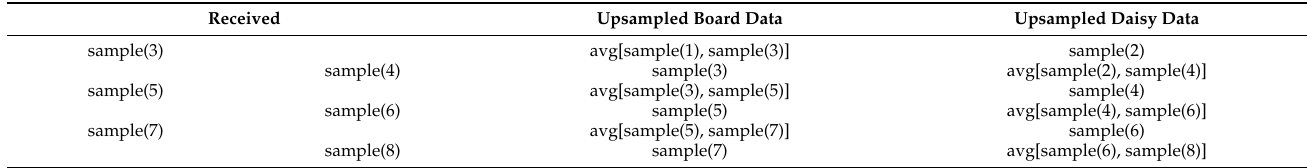
Table 4. EEG data package format for 16